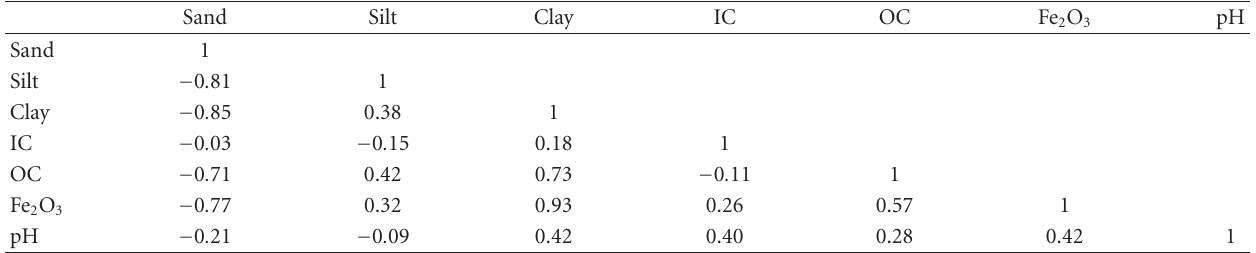
Figure 2: Physical and chemical characteristics of the soil samples ( n = 135) from the test site DEMMIN: particle size fractions sand (63–2000 µ m), silt (2–63 µ m), and clay (0–2 µ m) (a) and total carbon (TC), organic carbon (OC), inorganic carbon (IC), and iron content (Fe 2 O 3 ) (b). Table 2: Correlation matrix of the physical and chemical soil